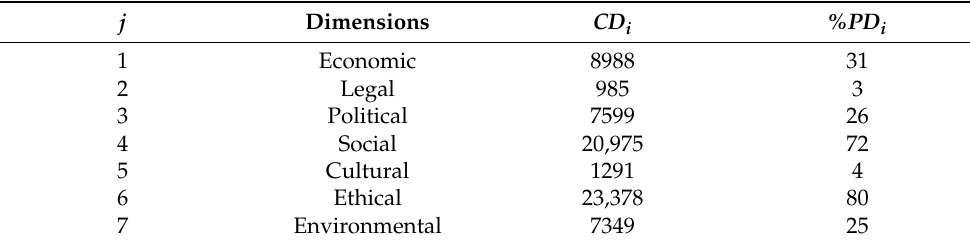
Table 2. Scope dimension.